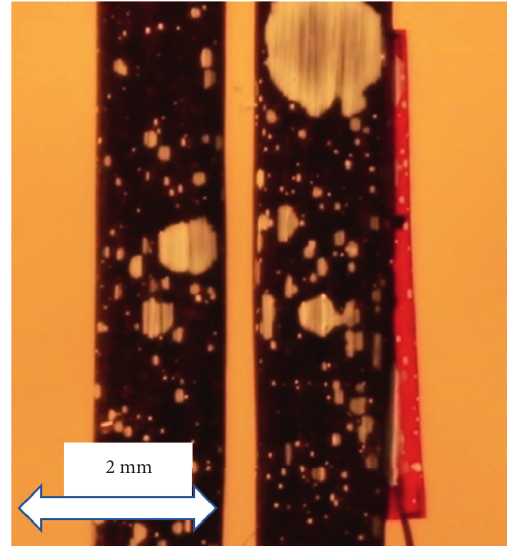
Figure 7: Zoomed area of strain gauge location of